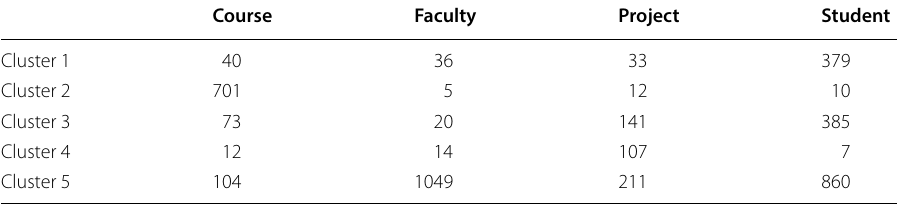
Maximum accuracy is italicized Table 10 The category distribution in clusters generated by PDSM (WebKB, tf-normal) Course Faculty Project Student